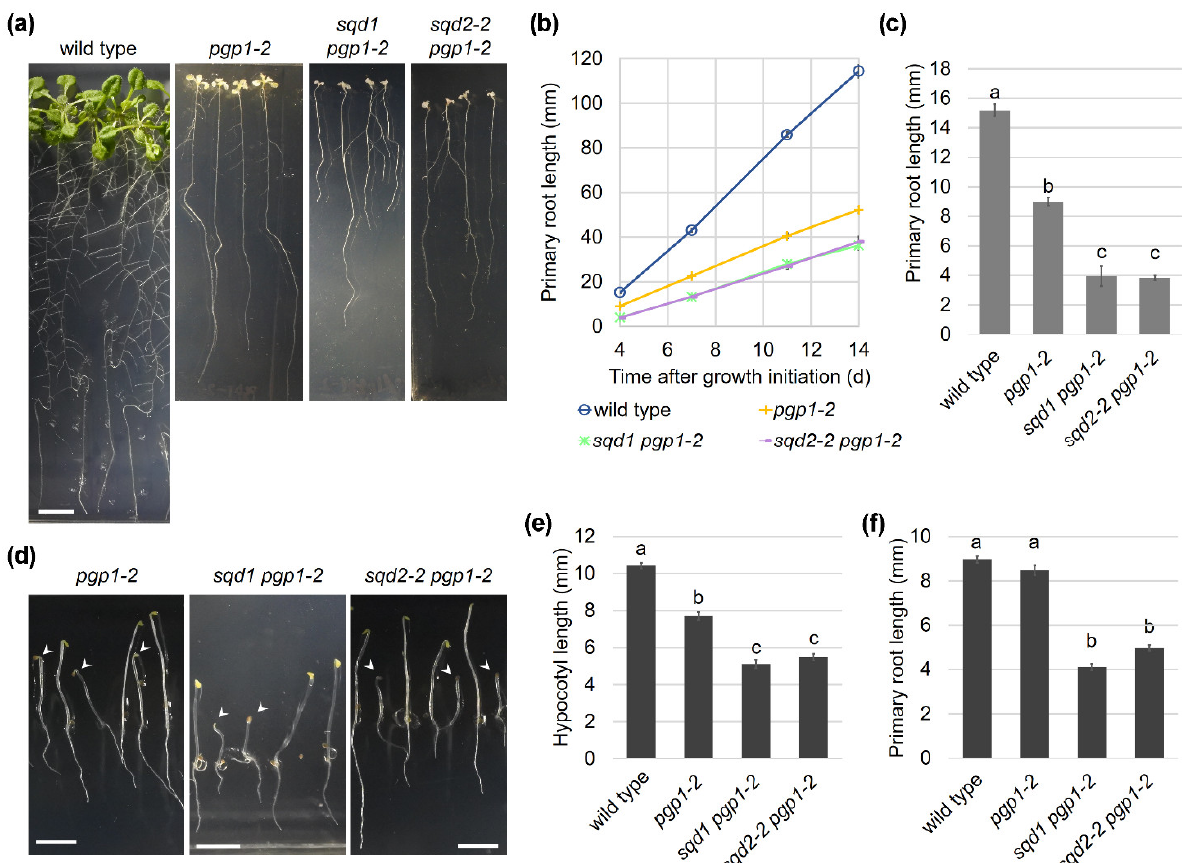
Figure 7. Impaired root growth of knockout mutants of anionic lipid biosynthesis in plastids. ( a ) Root phenotype of each line grown under light for 14 d. All photographs are in the same scale (bar = 10 mm). ( b ) Changes in primary root length during seedling growth under light. ( c ) Primary root length of 4-d-old seedlings grown under light. In ( b , c ), data are means ± SE of 194, 80, and 84 seedlings for pgp1-2 , sqd1 pgp1-2 , and sqd2-2 pgp1-2 , respectively. ( d ) Phenotype of etiolated seedlings of each line grown in the dark for 4 d. Arrowheads indicate seedlings with the homozygous pgp1-2 allele for each line. Scale bar = 5 mm. ( e , f ) length of primary root ( e ) and hypocotyl ( f ) of 4-d-old seedlings grown under dark. Data are means ± SE of 299, 205, 81, and 112 seedlings for wild type, pgp1-2 , sqd1 pgp1-2 , and sqd2-2 pgp1-2 , respectively. In ( b,c,f ), the data for wild type in Figure 1 were shown for reference.